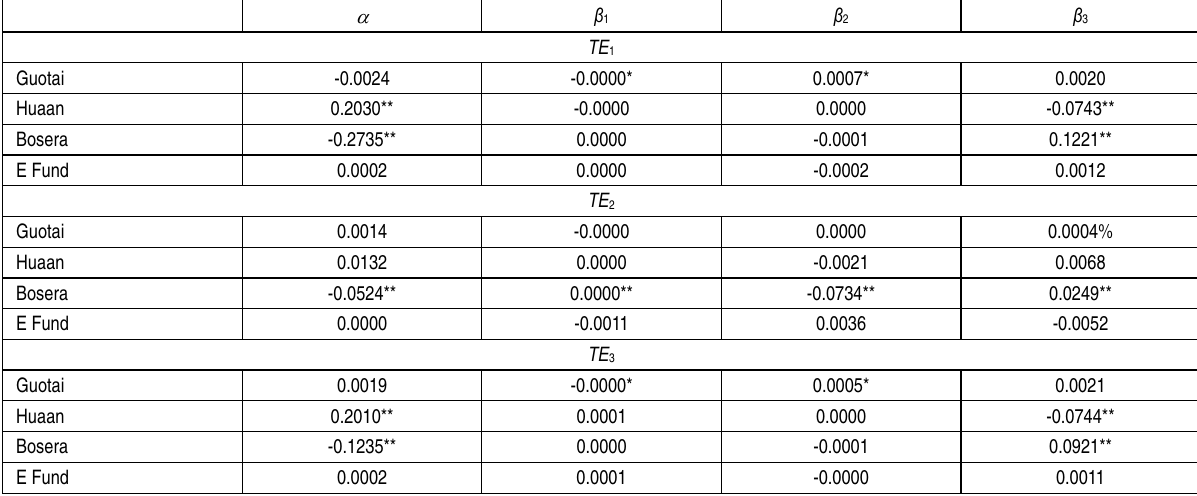
Table 3. The determinants of tracking